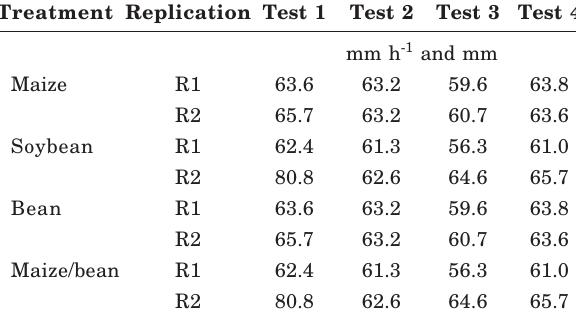
Table 1. Intensity and height of simulated rainfall applied for 1 hour per replication (R), in different treatments in four rainfall